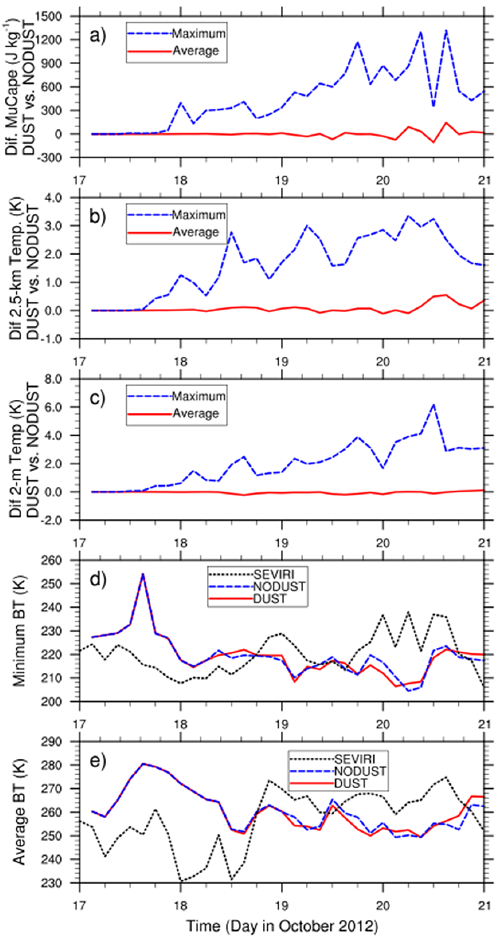
Figure 10. (a) 3-hourly evolution of the maximum MuCAPE differ- ence (dashed blue line) in the CV domain and the MuCAPE differ- ence averaged over the CV domain (solid red line) between DUST and NODUST from 00:00UTC on 17 October to 00:00UTC on 21 October 2012. (b) same as (a) but for the temperature difference at 2.5kma . m . s . l . (c) same as (b) but at 500 am.s.l. (d) 3-hourly evo- lution of the minimum 10.8µm BT in NODUST (dashed blue line) and in DUST (solid red line) in the CV domain. The dotted line is the minimum BT in the CV area observed with SEVIRI. (e) same as (d) but for the 10.8µm BT averaged over the CV